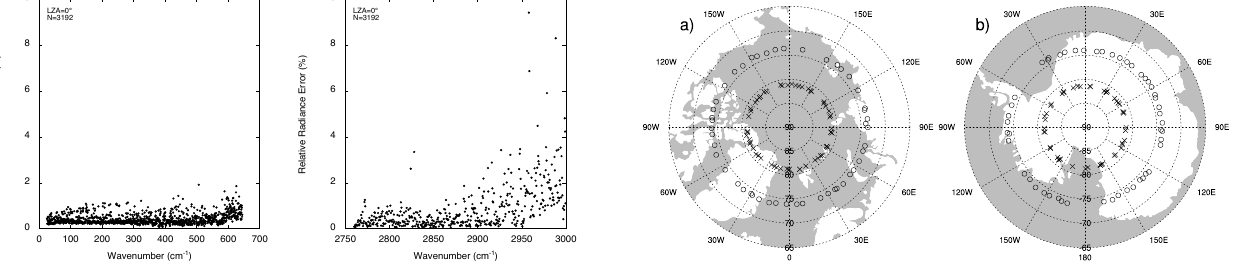
Figure 7. Relative radiance estimation error for the FIR (left) and the NIR (right) regions. Calculated from the rms values of the ra- diance errors divided by the mean radiance spectrum (the right and left plots of Figs. 5 and 6, respectively).